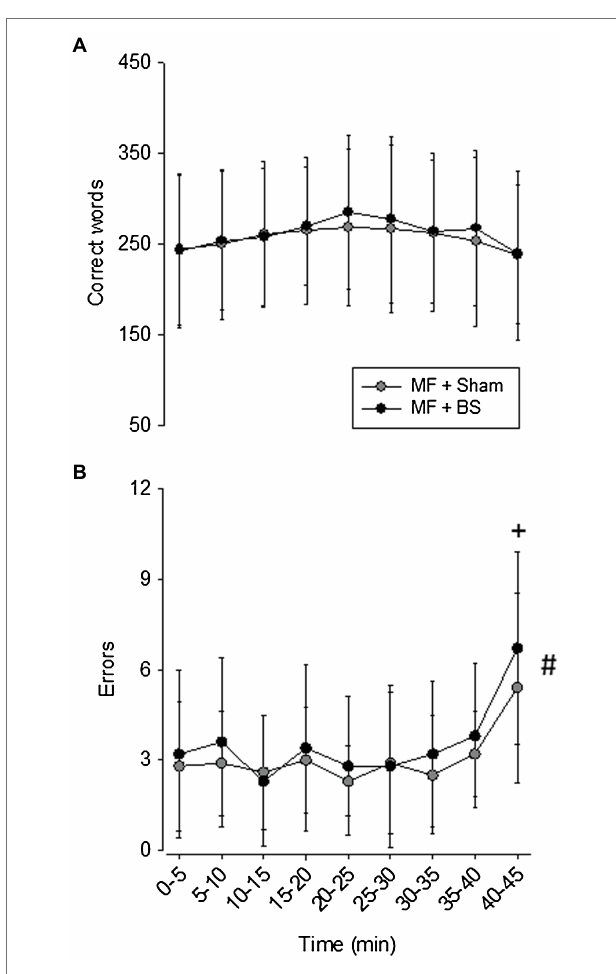
FIGURE 3 | Number of correct words (A) and errors (B) during the 45-min Stroop Color Test. Data are expressed as mean ± standard deviation. + means a significant difference from all other time points for both conditions ( p < 0.05). # means a significant main effect of time ( p <